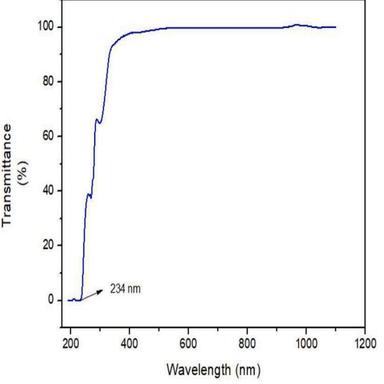
UV–vis Transmittance spectrum of G4C3NBM.